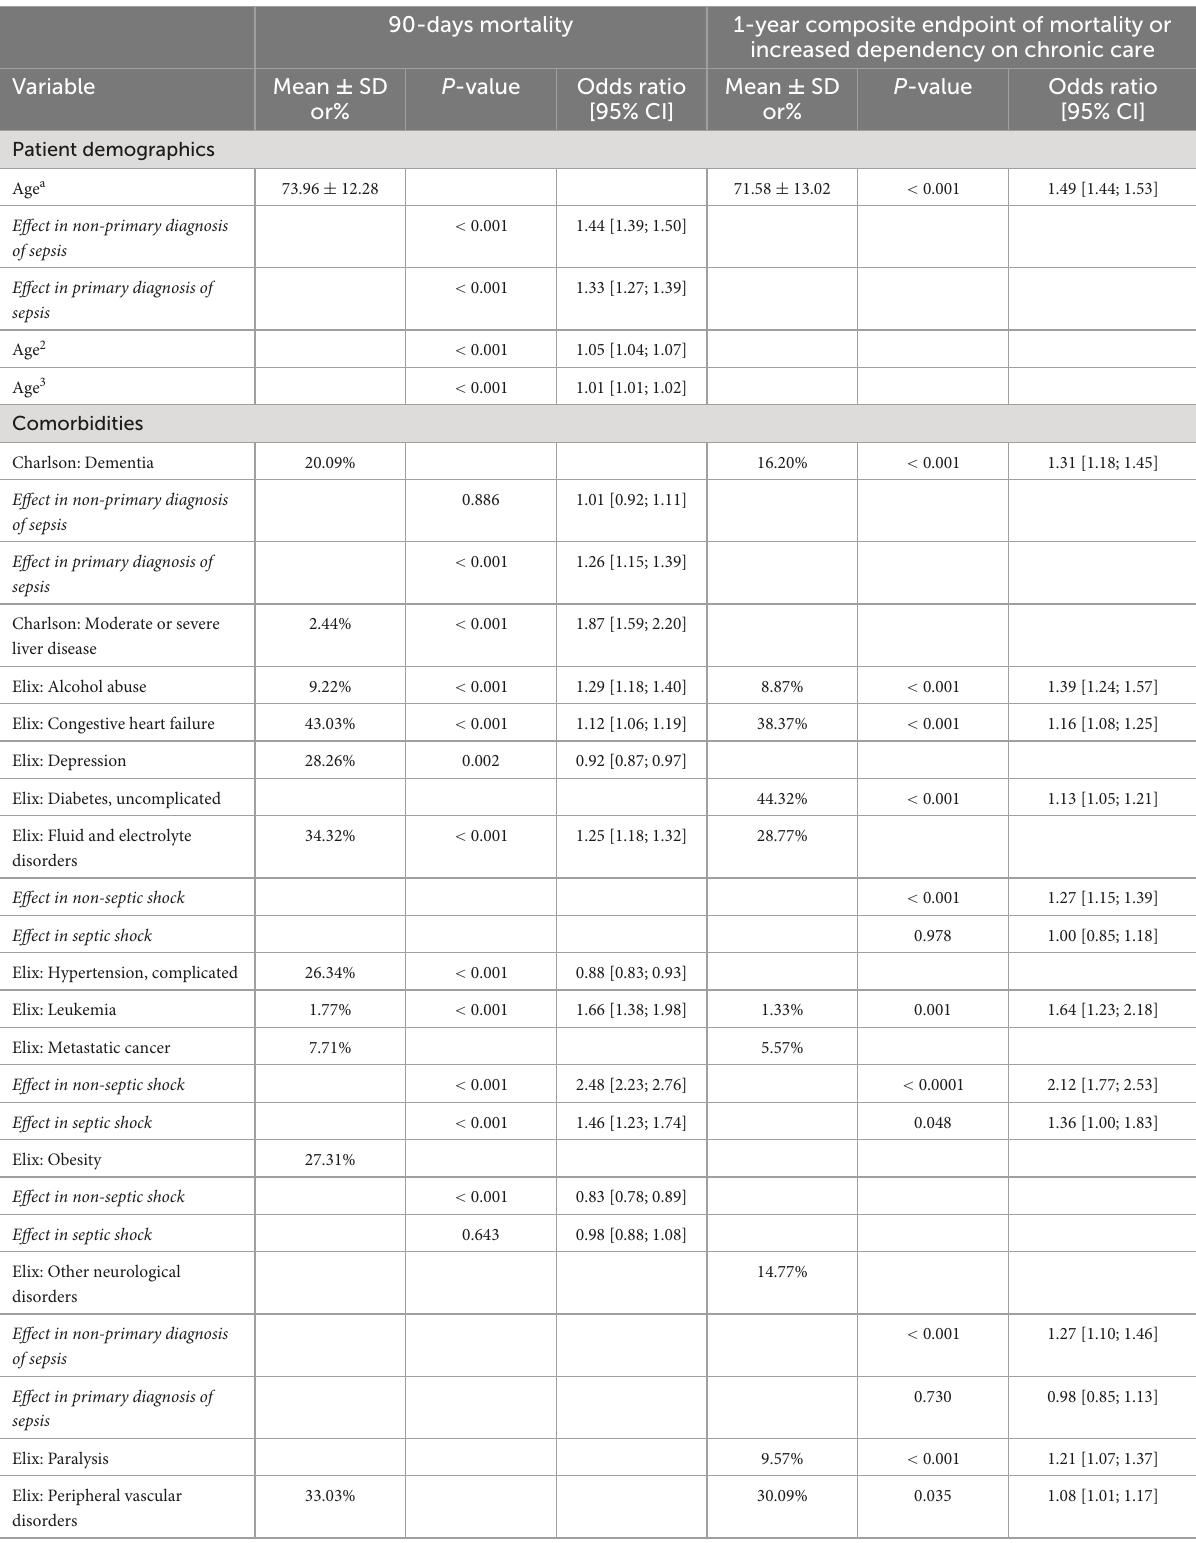
TABLE 2 Coefficients estimates of the risk-adjustment model for 90-days mortality and 1-year composite endpoint of mortality or increased dependency on chronic